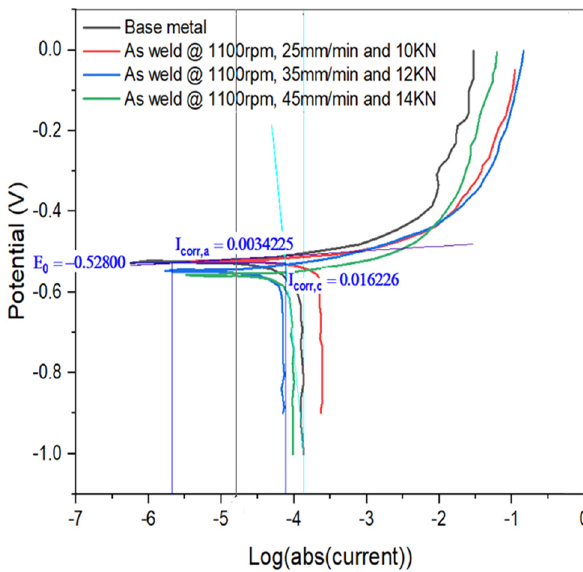
Figure 7: Tafel plots of base metal and FSW 4 , and FSW 3 samples FSW 5 , and FSW 6 samples.